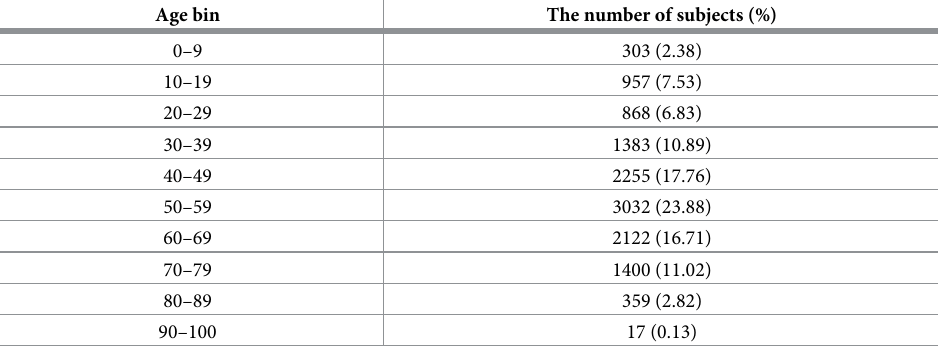
Table 4. The table of age distribution on 12,697 subjects.